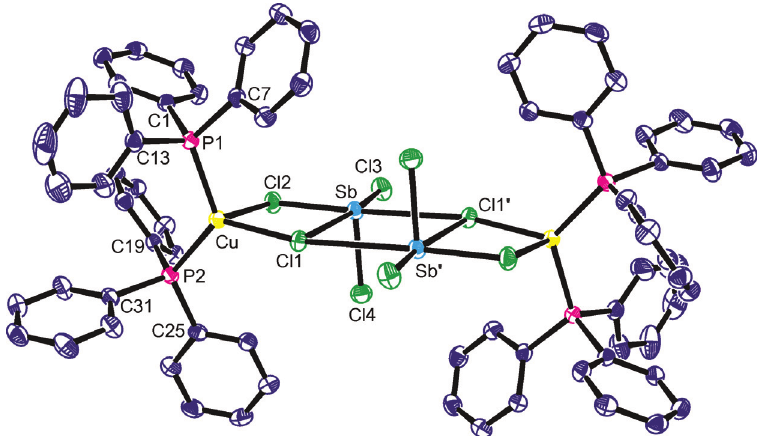
Figure 6 The asymmetric unit of 6 showing the labeling scheme used. Thermal ellipsoids are at the 40% probability level. Only the α -carbons of the phenyl rings are shown for clarity, whereas hydrogen atoms have similarly been omitted. Selected geometric data: Sb-Cl(1) 3.0736(7), Sb-Cl(2) 2.3899(7), Sb-Cl(3) 2.3875(8), Sb-Cl(4) 2.3474(8), Sb-Cl(1′) 3.2106(6), Cu-Cl(1) 2.3129(7), Cu-Cl(2) 3.0070(9), Cu-P(1) 2.2701(8), Cu-P(2) 2.2668(8) Å; Cl(1)-Sb-Cl(2) 79.31(2), Cl(1)-Sb-Cl(3)